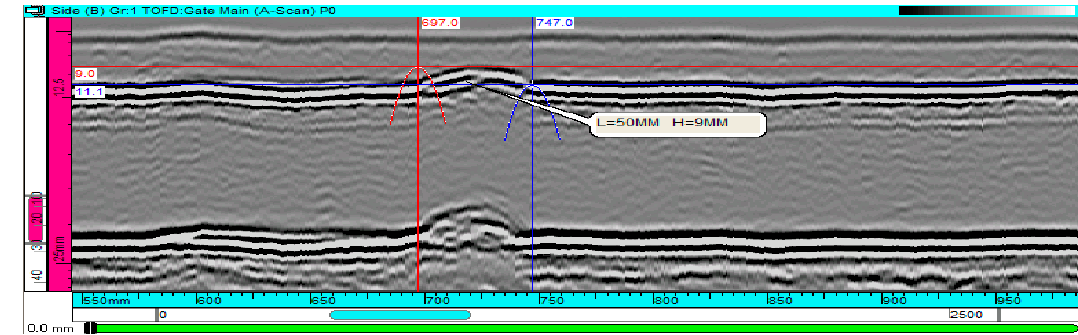
Figure 7. Time of flight diffraction technique (TOFD) inspection of the linear defect at the root of the weld.